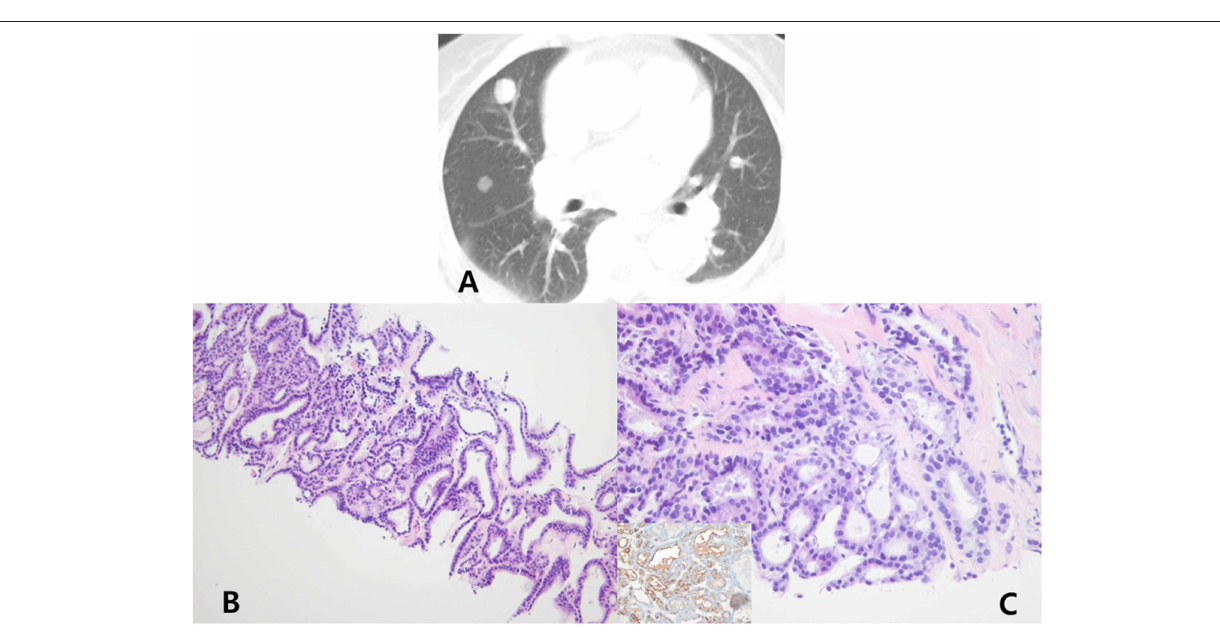
FIGURE 2 | Chest computed tomography (lung window) (A) show multiple, variable-sized nodules in both the lungs. Computed tomography-guided transthoracic core needle biopsy was performed for the lung nodule in the right upper lobe. The biopsied lung mass was composed of cells with an irregular follicular pattern (hematoxylin and eosin stain, × 100) (B) . The follicular cells show nuclear enlargement, irregularity, and grooves (hematoxylin and eosin stain, × 400), which were positive for thyroglobulin, thyroid transcription factor-1, and HBME-1 immunohistochemical stain (inset) (C)